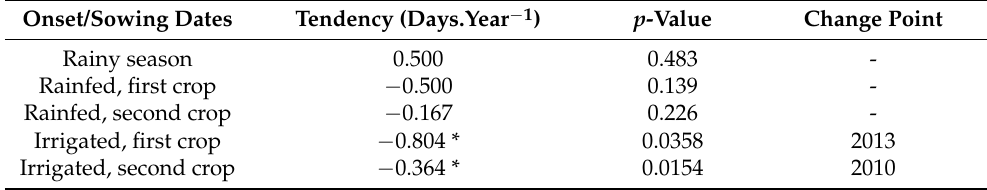
Table 1. Tendency in rainy season onset and sowing dates for Western